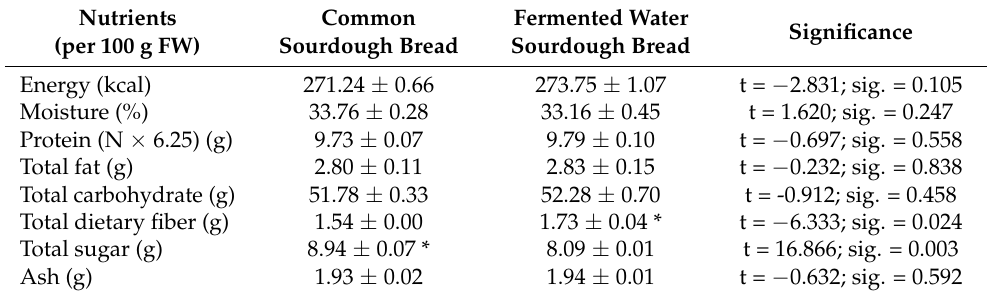
Table 3. Nutritional values of common sourdough bread and fermented water sourdough bread. Nutrients Common Fermented Water (per 100 g FW) Sourdough Bread Sourdough Bread